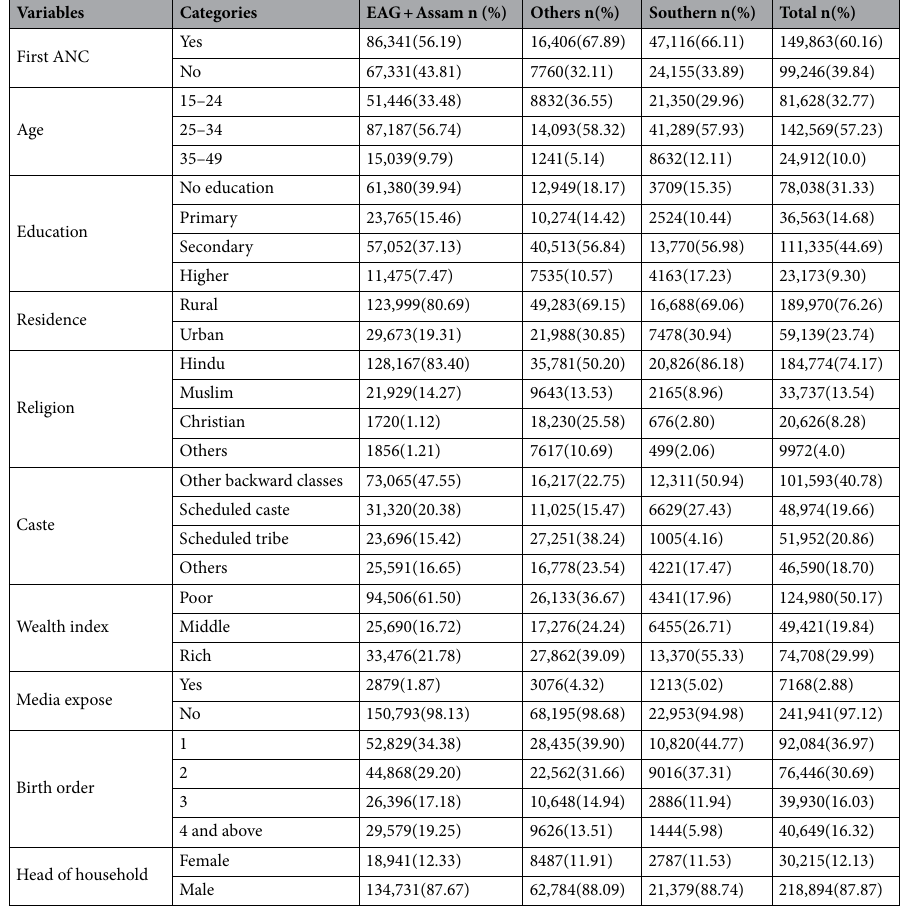
Table 1. Proportion of study participants and its distribution by demographic characteristics across regions (EAG plus Assam, Others states and Southern states) from NFHS-4